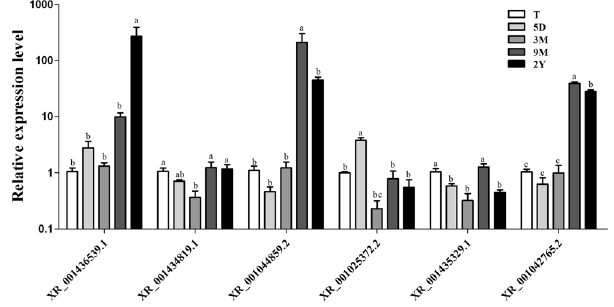
Figure 9. The expression level of six randomly selected differential expressed lncRNAs of different ages. The relative expression of screened DE lncRNAs in testis was determined using qRT-PCR. T, 5D, 3 M, 9 M, and 2Y represent prenatal embryo at 110 days and postnatal at 5 days, 3 months, 9 months, and 2 years. The experiment was biologically repeated 3 times and technically repeated 3 times for each group. The relative expression levels were normalized to the expression amount of GAPDH . Results are expressed relative to the prenatal embryo at 110 days as the mean ± the SEM. ( a , b , c ) Different letters denote statistically significant differences within each group; * p < 0.05, and the Y-axis represents the values that were calculated by